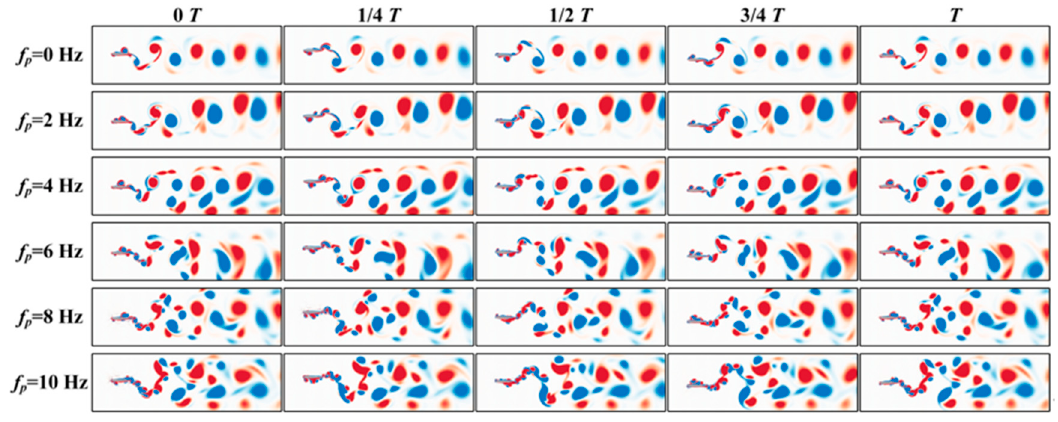
Figure 8. Instantaneous wake structure for foil at k = − 1.